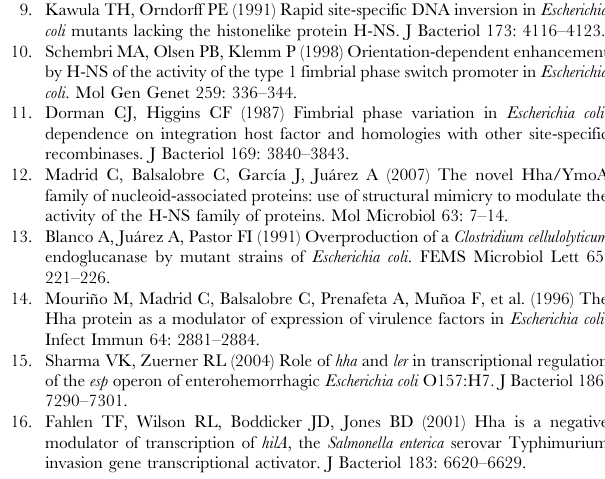
Table S1 E. coli BW25113 genes induced more than two fold (P , 0.05) in biofilms upon deleting hha in at least two of the following conditions: LB 4 h, LB glu 4 h, LB glu 15 h, and LB glu 24 h. Found at: doi:10.1371/journal.pone.0002394.s003 (0.12 MB Table S2 E. coli BW25113 genes repressed more than two fold (P , 0.05) in biofilms upon deleting hha in at least two of the following conditions: LB 4 h, LB glu 4 h, LB glu 15 h, and LB glu 24 h.